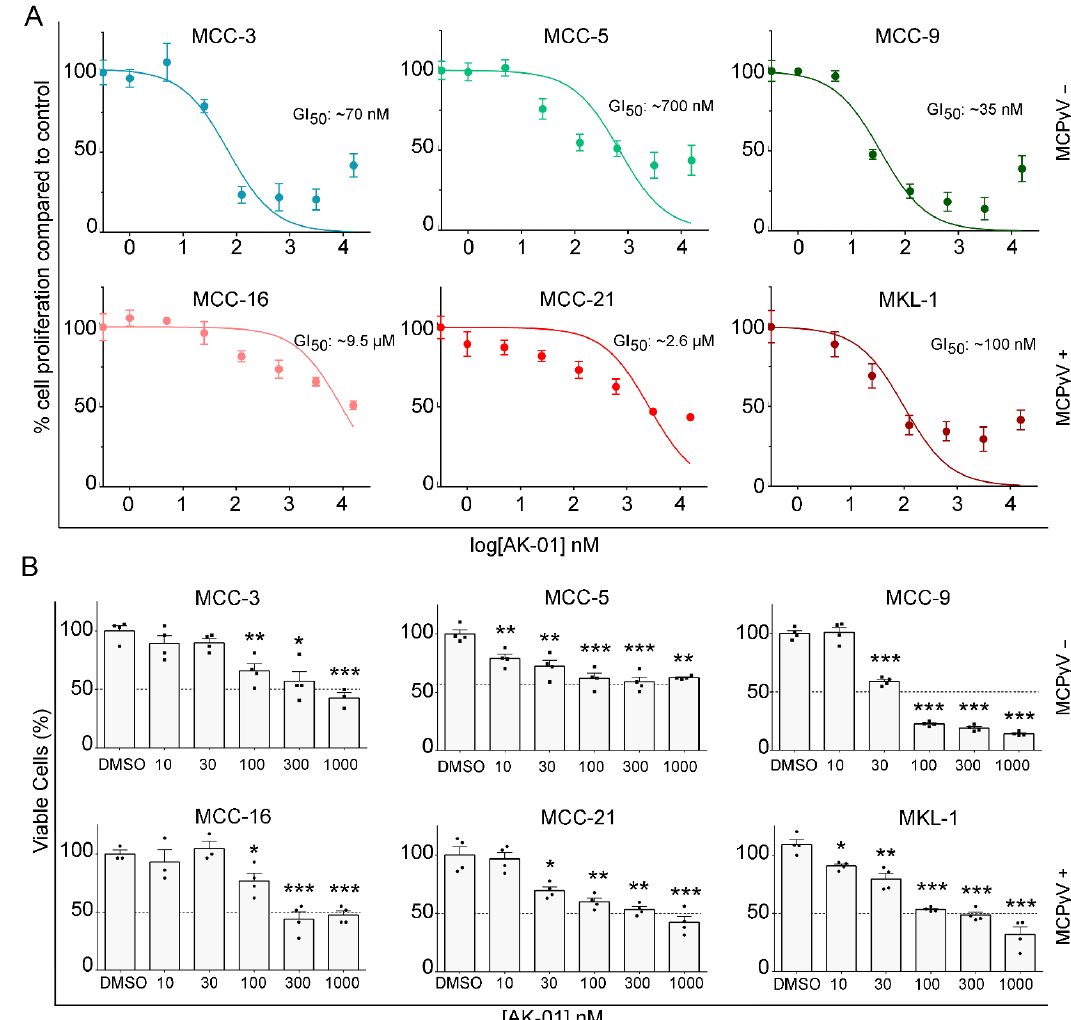
Figure 1. AK-01 attenuates cell viability of MCC cells in vitro. Six MCC cell lines were treated with vehicles (DMSO) of increasing concentrations of AK-01 for 72 h. ( A ) Cell proliferation was assessed by CCK-8 assay with reference maxima (100%) defined as the mean proliferation for vehicle-treated controls. Half maximal growth inhibitory concentration (GI 50 ) was calculated by nonlinear regression analysis [GraphPad Prism 6.0, “log (inhibitor) vs. normalized response” dose- response curve equation]. Data presented as mean percent proliferation ± SEM of vehicle control from three experiments ( n = 6). ( B ) Live cells were quantified by trypan blue dead-cell exclusion staining. Data presented as mean percentage ± SEM of vehicle-treated control ( n = 3). Dotted line represents 50% cell viability. Experiments were repeated three times. * refers to p < 0.05, ** refers to p < 0.005, and *** refers to p < 0.0005 vs. DMSO- treated cells by paired Student’s t -test.